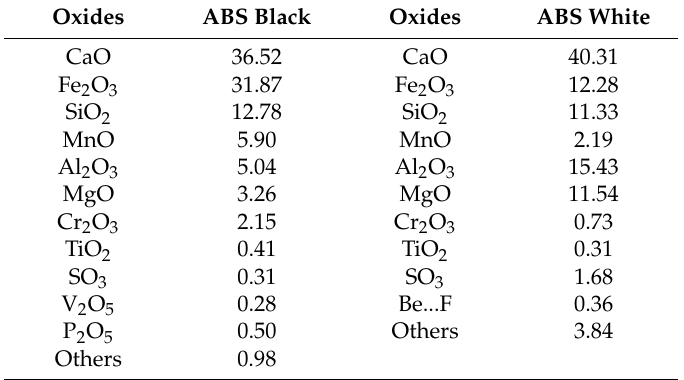
Table 1. Chemical compositions (wt %) of black and white steel slag (EUROPEAN STANDARD EN 15309 by